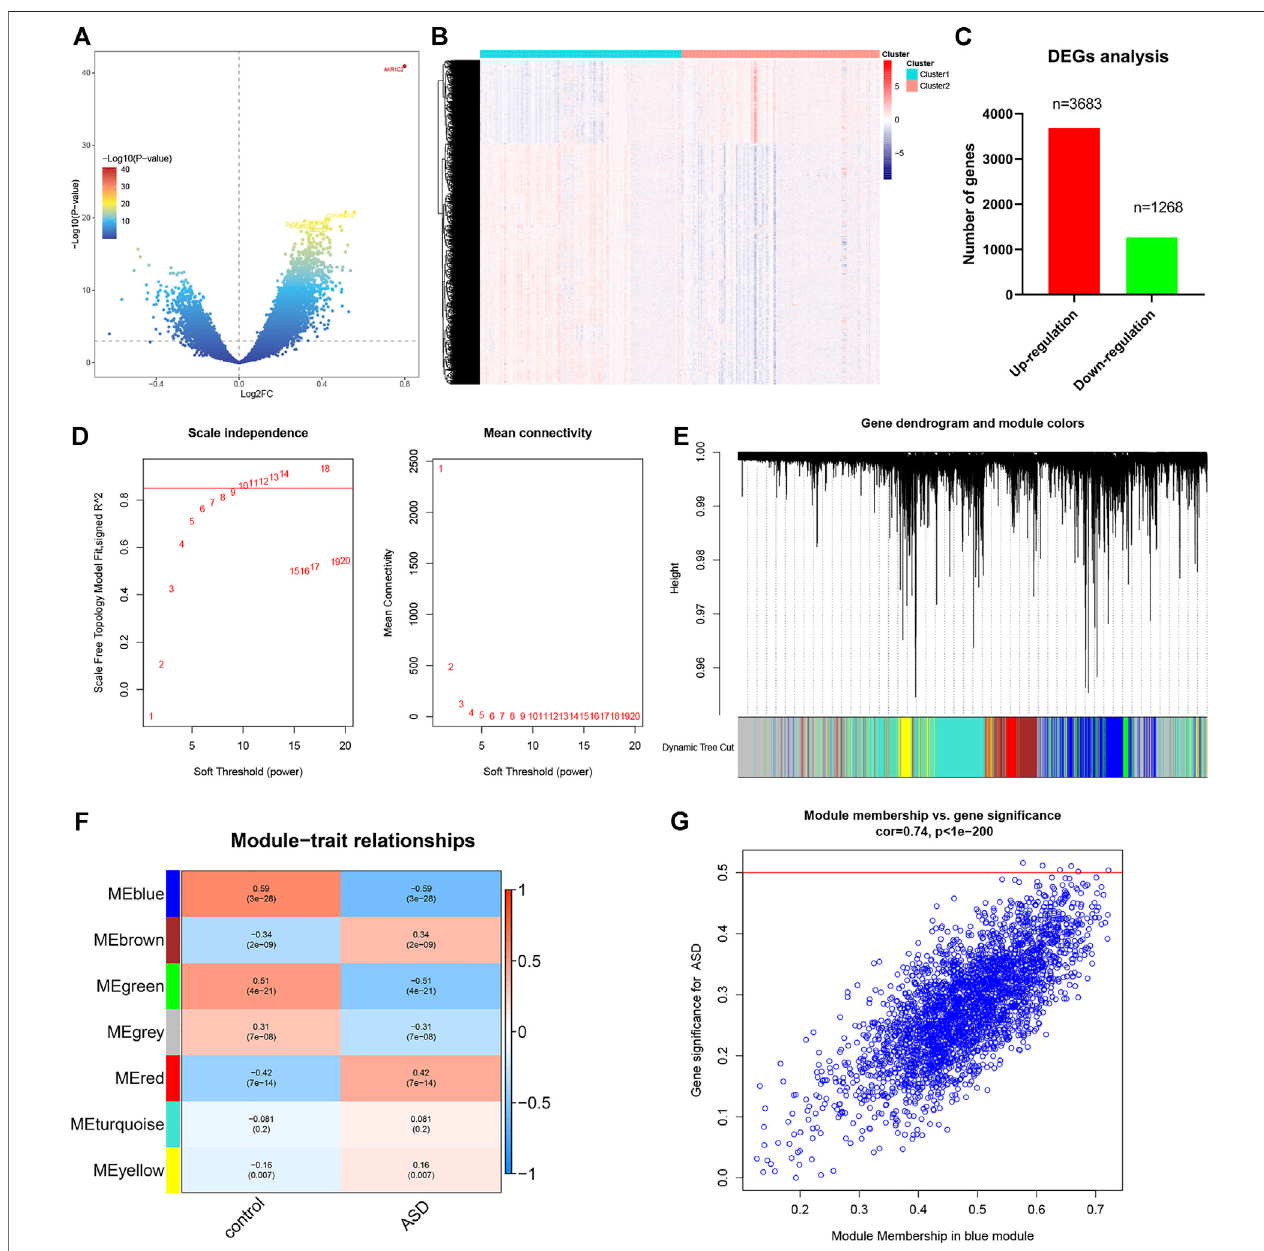
FIGURE 7 | Identi fi cation of DEGs between ferroptosis subtypes. (A and B) Volcano plot (A) and heatmap (B) showing DEGs between ferroptosis subtypes. (C) QuantitativeresultsofthenumberofupregulatedanddownregulatedDEGs. (D) Analysisofscale-free fi ttingindex andaverageconnectivityforvarious soft-thresholding parameters. (E) Representativegeneclusteringdendrogramsbasedonthedistincttopologicaloverlapandmodulecolors. (F) Representativemodule-traitheatmapwas establishedbasedon theeigenvalues valuesofthemodules. (G) Representativescatterplotshowingthecorrelation betweenthebluemoduleand module-related